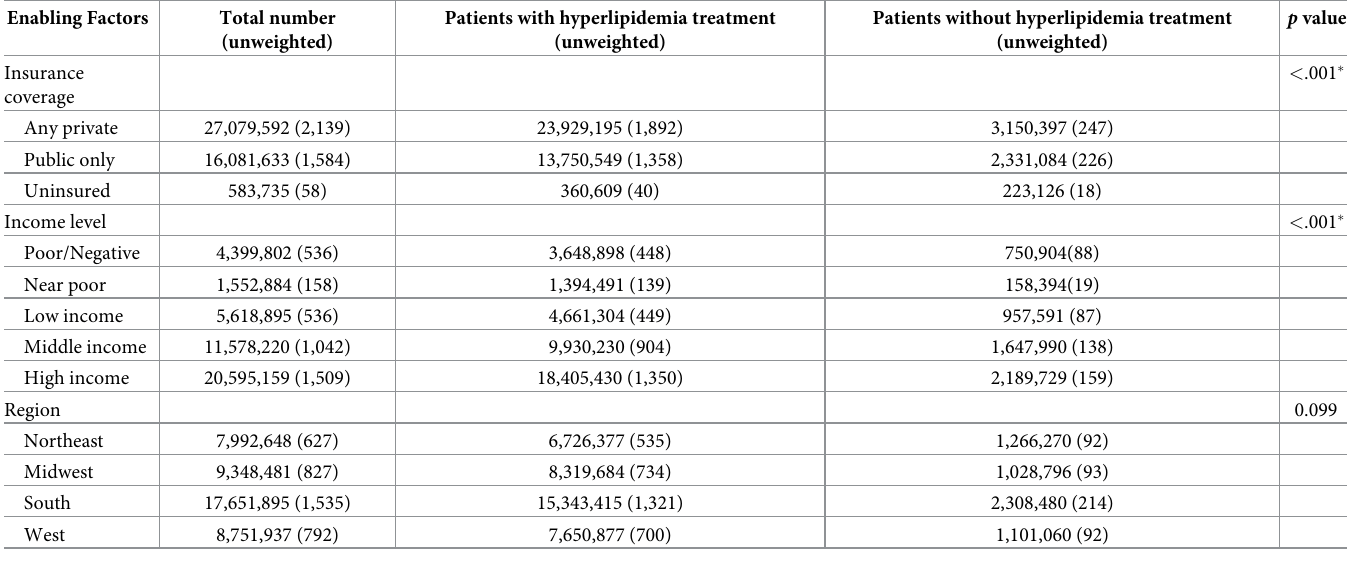
Table 2. Population characteristics; enabling